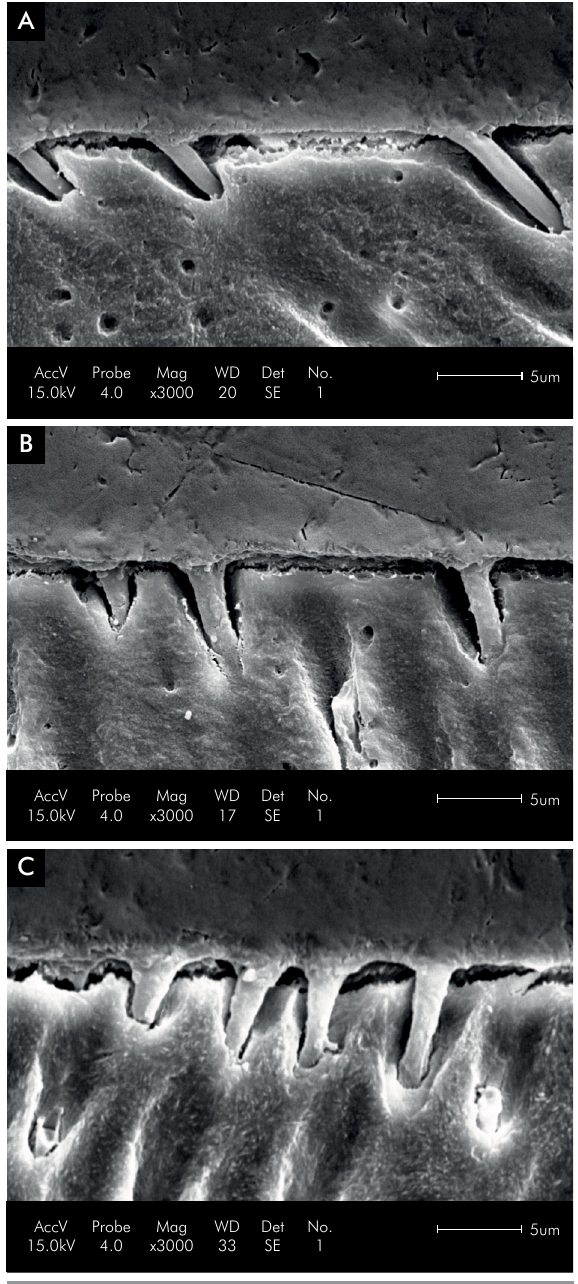
Figure 3. SEM pictures of bonded interfaces. The resin tags observed for the groups BDO and PA had a trunk-conical- shape with a rough surface similar to